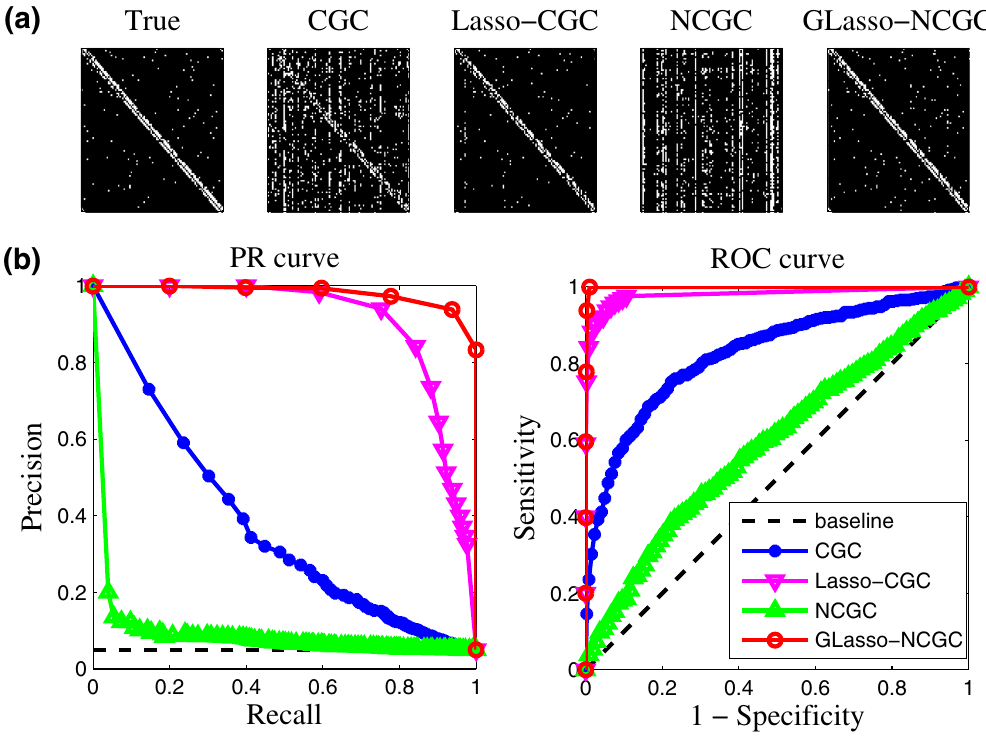
Figure 8. Simulation of GRN model on SW network ( N = 100, k = 5, M = 400). ( a ) True network and reconstructed network inferred by different methods with noise . (0,0 1 ) 2  . ( b ) PR curves and ROC curves with noise . (0,0 1 ) 2 